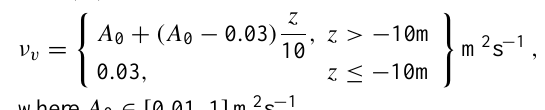
FIG. 2: Time series of the vertical velocity component w at the four indicated (inset in panel b) near-shore midpoints at 30 m depth in the homogeneous rectangular basin of constant depth, subject to constant wind from the West. Results were obtained with three different vertical eddy viscosities ν v . N denotes the number of Chebyshev polynomials needed to achieve stable and convergent numerical computations.